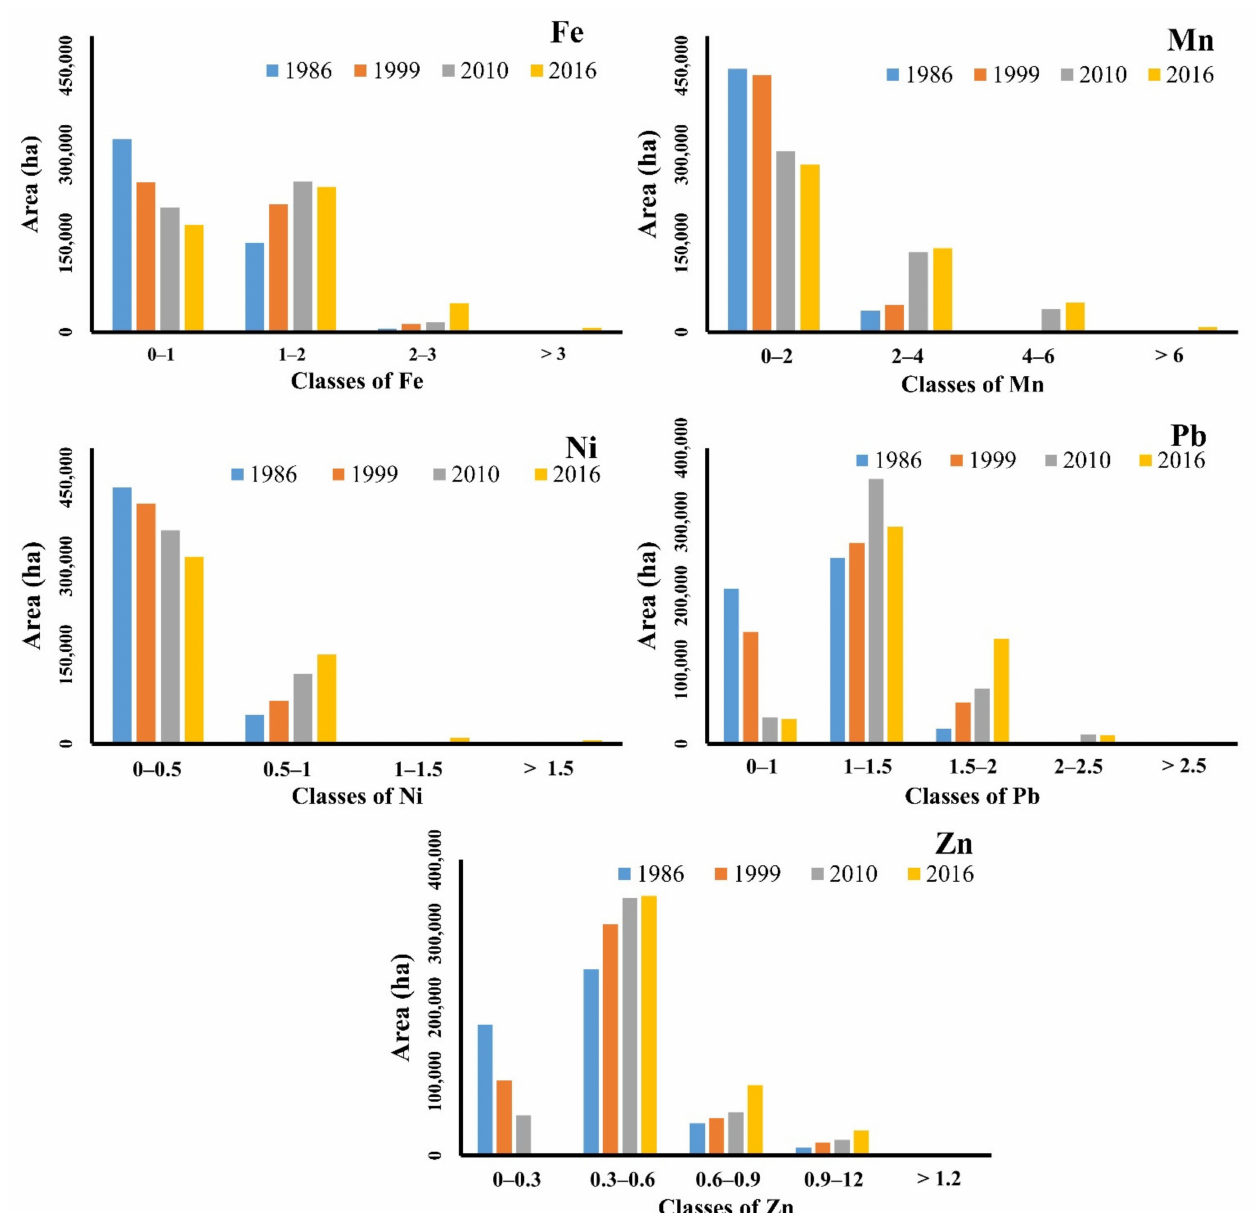
Figure 11. Bar charts showing the predicted percentage of different classes of each heavy metal for 1986, 1999, 2010, and